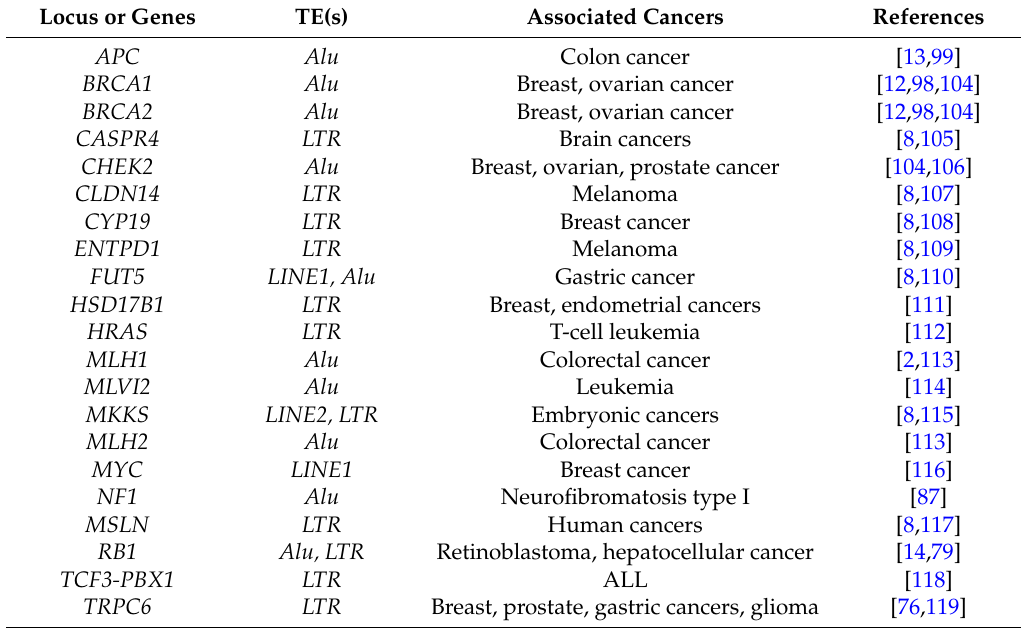
Table 2. TE insertion-associated loss or gain of a few base pairs and mutagenesis in human cancers. Locus or